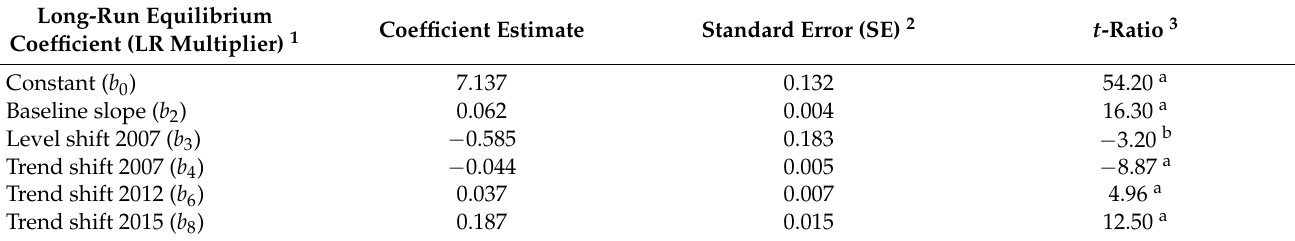
Table 3. Estimates of long-run equilibrium changes in dfr trend slopes and